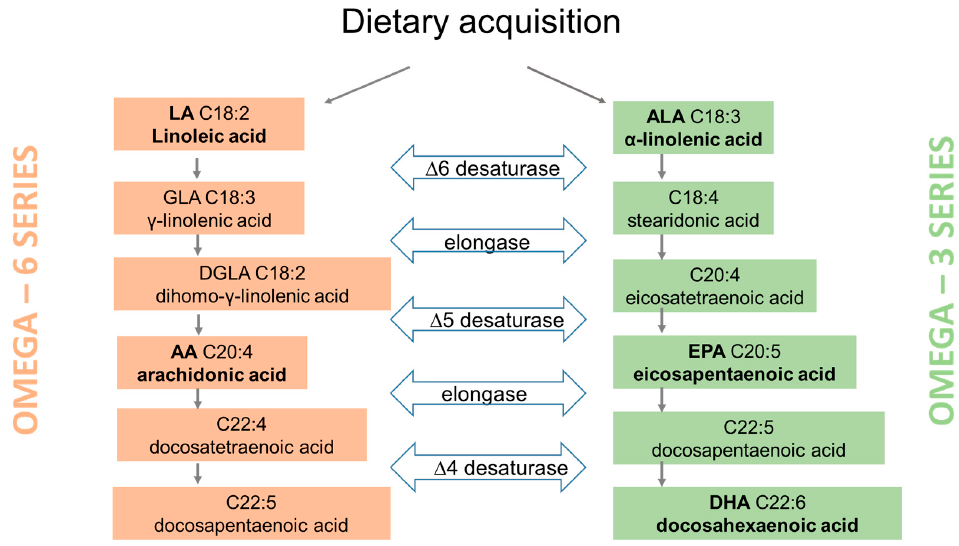
Figure 1. Biosynthetic pathways for omega 6 and omega 3 polyunsaturated fatty acids. Those highlighted in bold are known for their immunomodulatory actions in inflammation.